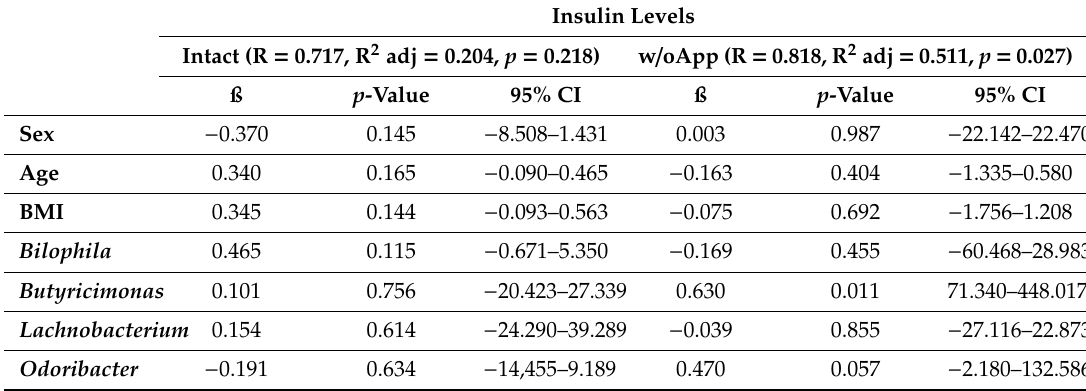
Table 2. Regression analysis with insulin levels as dependent variable and sex, age, BMI, Bilophila, Butyricimonas, Lachnobacterium and Odoribacter levels as independent